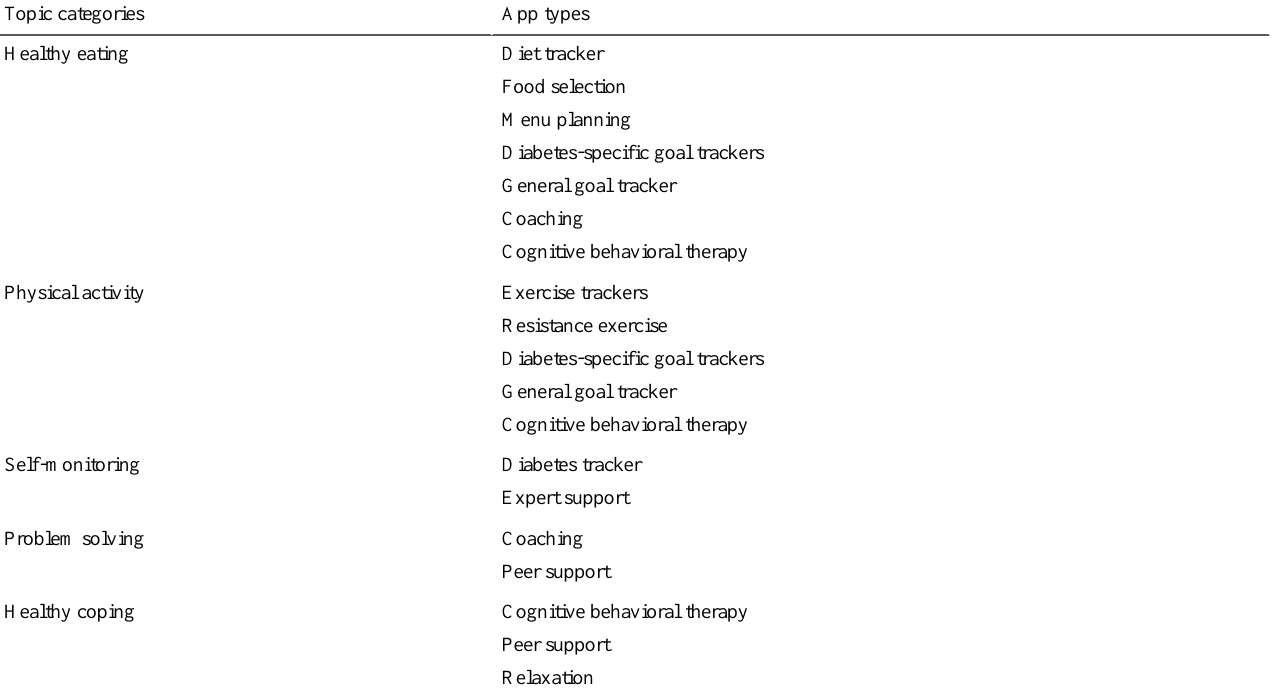
Table 2. Categorization of app types by